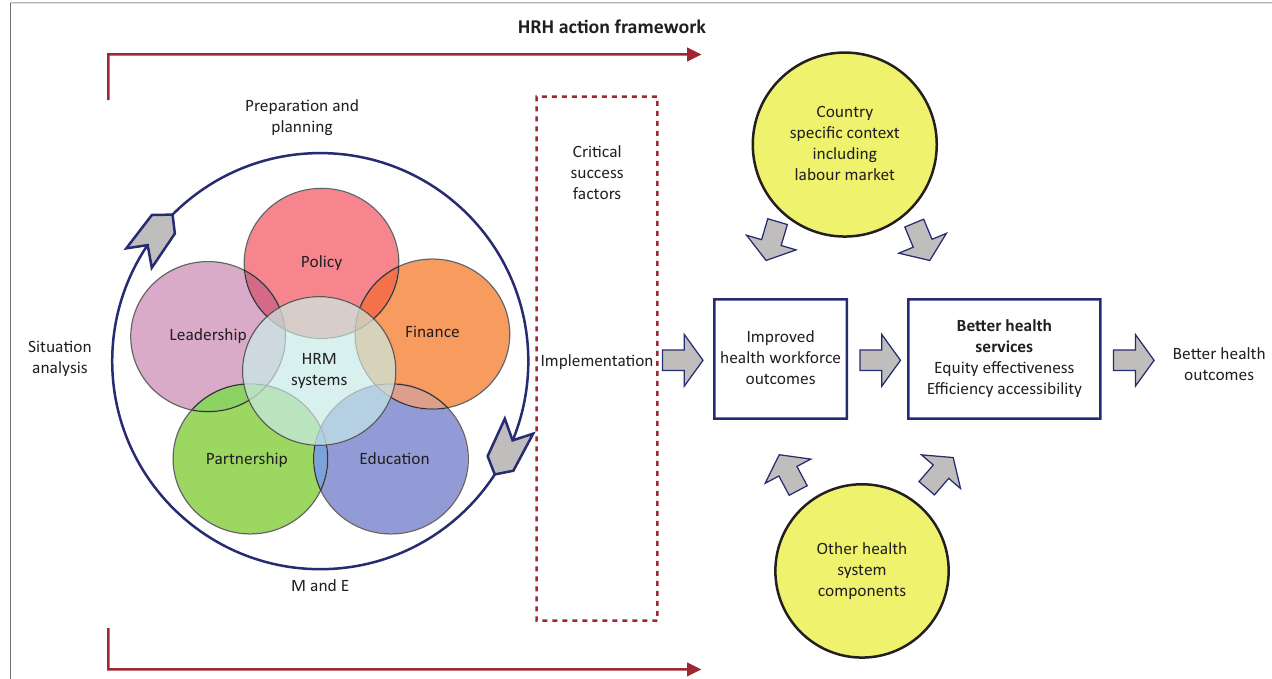
FIGURE 1: Human resources for health action